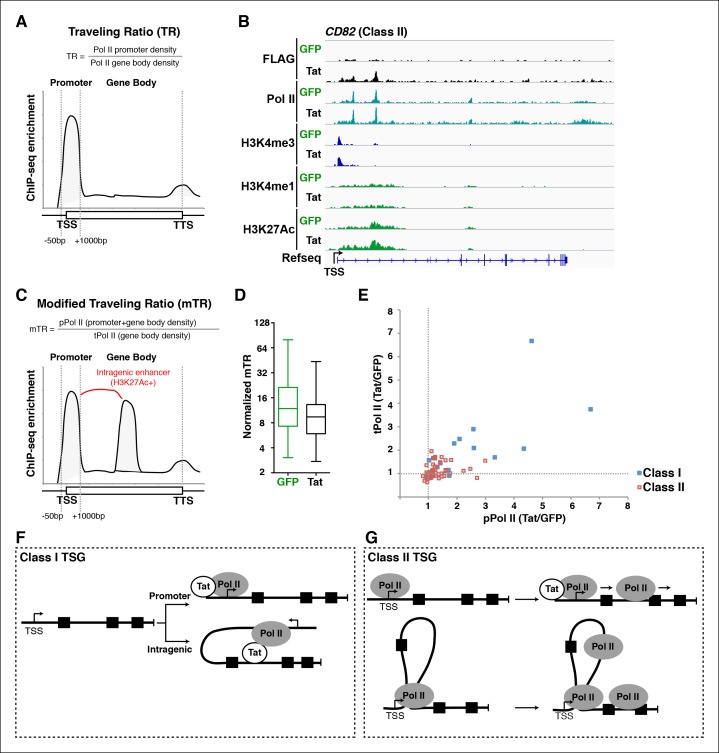
A modified traveling ratio algorithm reveals Tat roles in transcription elongation.(A) TR algorithm used to calculate levels of promoter-proximal paused and elongation Pol II as previously described (Rahl et al., 2010; Zeitlinger et al., 2007). (B) Genome browser views of ChIP-seq data at the CD82 locus in the GFP and Tat cell lines. (C) mTR algorithm that enables the identification of intragenically paused Pol II at sites of high H3K27Ac levels. (D) mTR decreases at TSG in the Tat cell line. Box plots showing mTR calculations at TSG as indicated in panel (C). (E) Dual-axis plot of the ratio of paused Pol II (pPol II) and traveling Pol II (tPol II) at class I (n = 17) and II (n = 43) TSG in the presence and absence of Tat (Tat/GFP). (F) Model of Tat-mediated Pol II recruitment and gene looping at class I TSG. Tat binds at promoter and/or intragenic regions (in some cases inducing gene looping), and recruits Pol II to promote transcription initiation from both promoter-proximal and promoter-distal sites. (G) Model of Tat-mediated Pol II elongation at class II TSG. Class II TSG are already activated in the absence of Tat, and Tat binds to these genes to primarily stimulate transcription elongation. These genes contain promoter-bound Pol II. This figure is associated with Figure 5—figure supplement 1. GFP, green fluorescent protein; Pol, polymerase; mTR, modified TR; TR, traveling ratio; TSG, Tat stimulated genes.